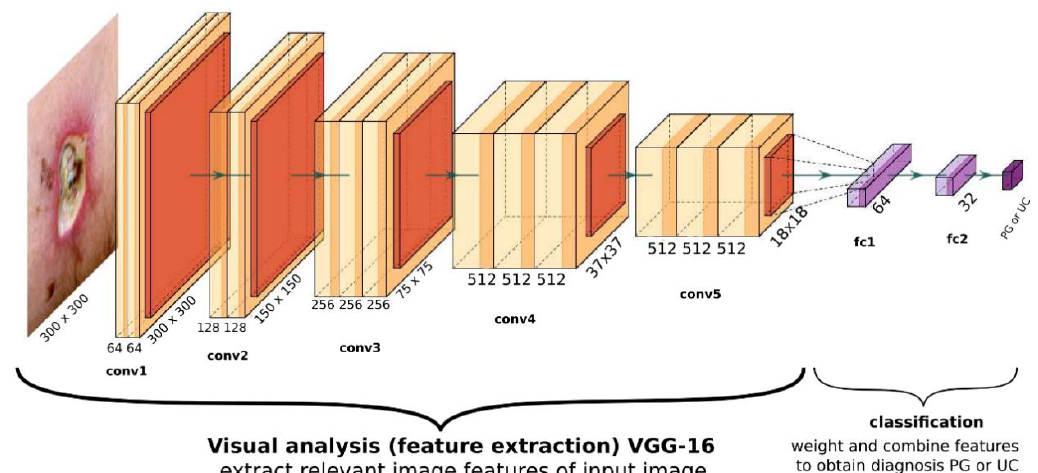
Figure 1. General overview of the optimal CNN’s structure. The visual part consists of a VGG16 architecture, with its final layer yielding 512 abstract features with size 18 × 18. The classifier consists of two fully connected dense layers with 64 and 32 neurons each, and a final two-neuron output yielding probability for PG and UC.